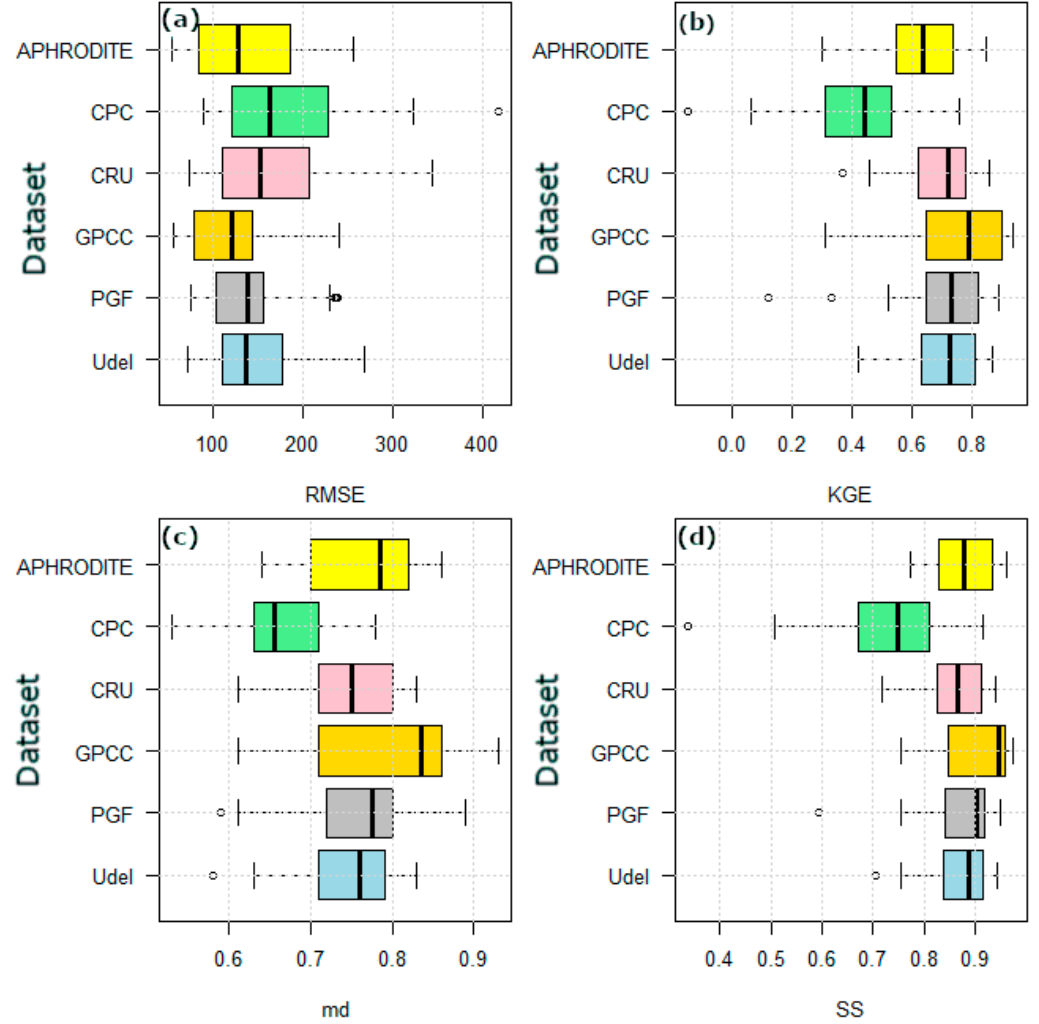
Figure 5. Box plots of the four indices—( a ) RMSE, ( b ) KGE, ( c ) md, and ( d ) SS—used to evaluate the performance of monthly gridded rainfall data against observed rainfall data recorded at 34 locations distributed over Bangladesh during 1979–2010 using point-to-point comparison method.